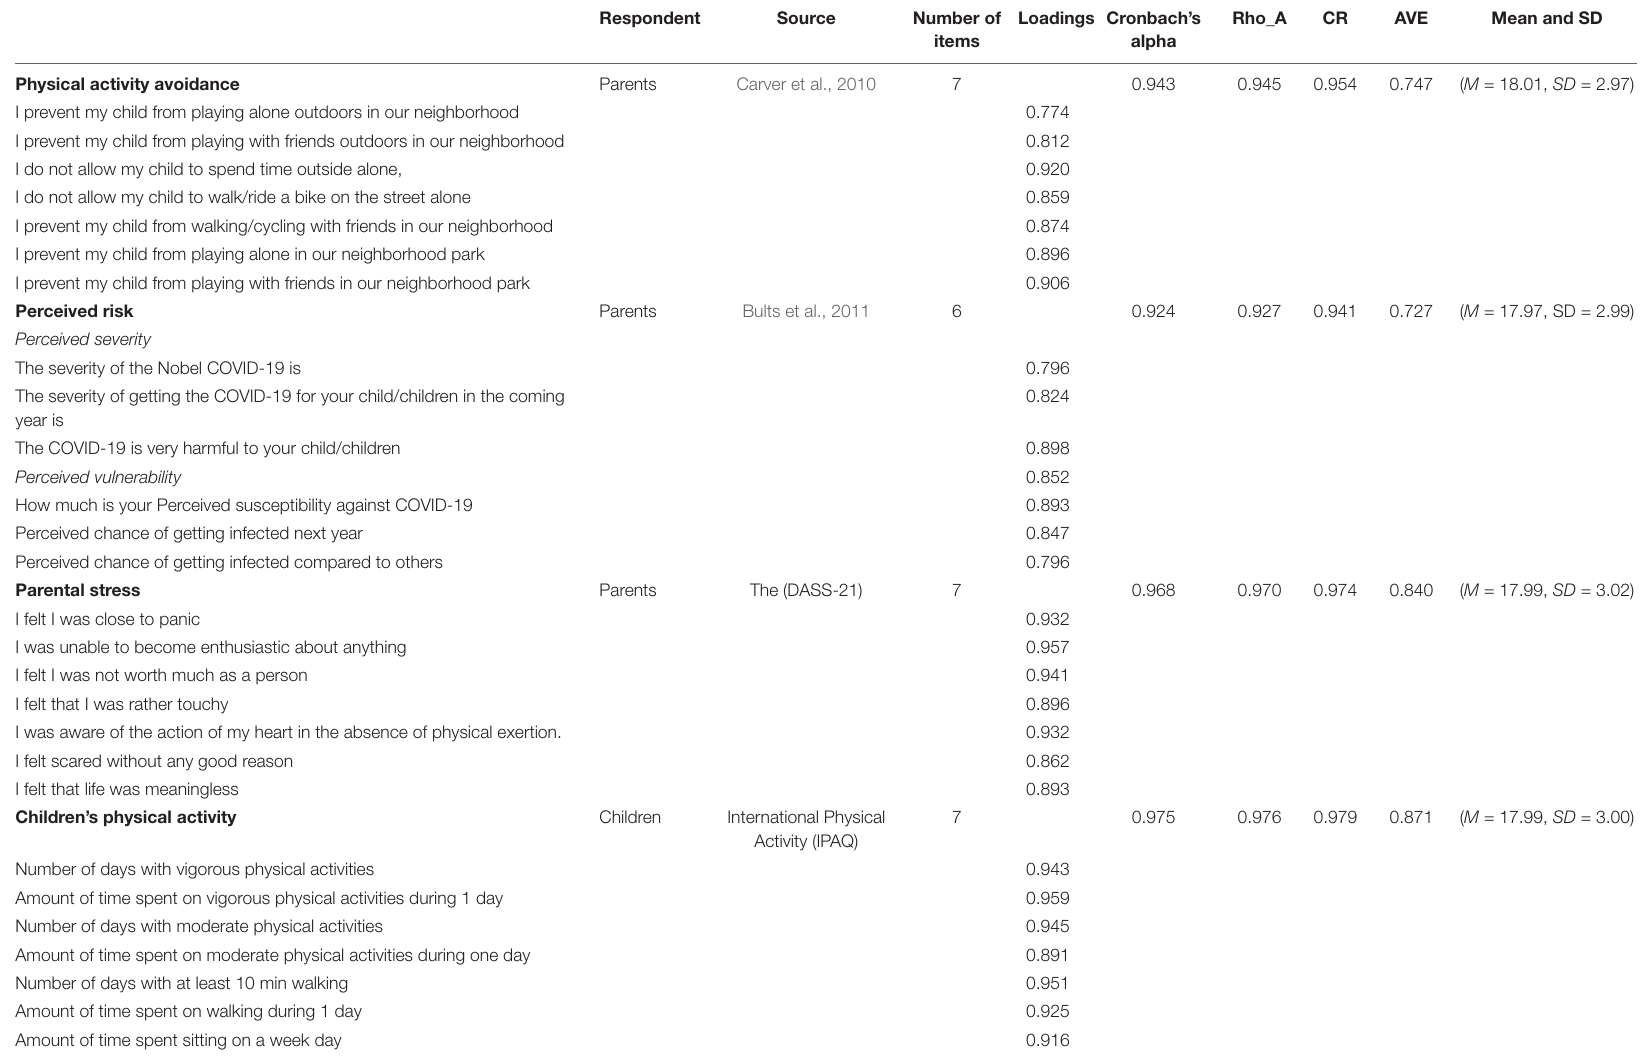
TABLE 2 | Descriptive statistics and reliability and convergent validity for research